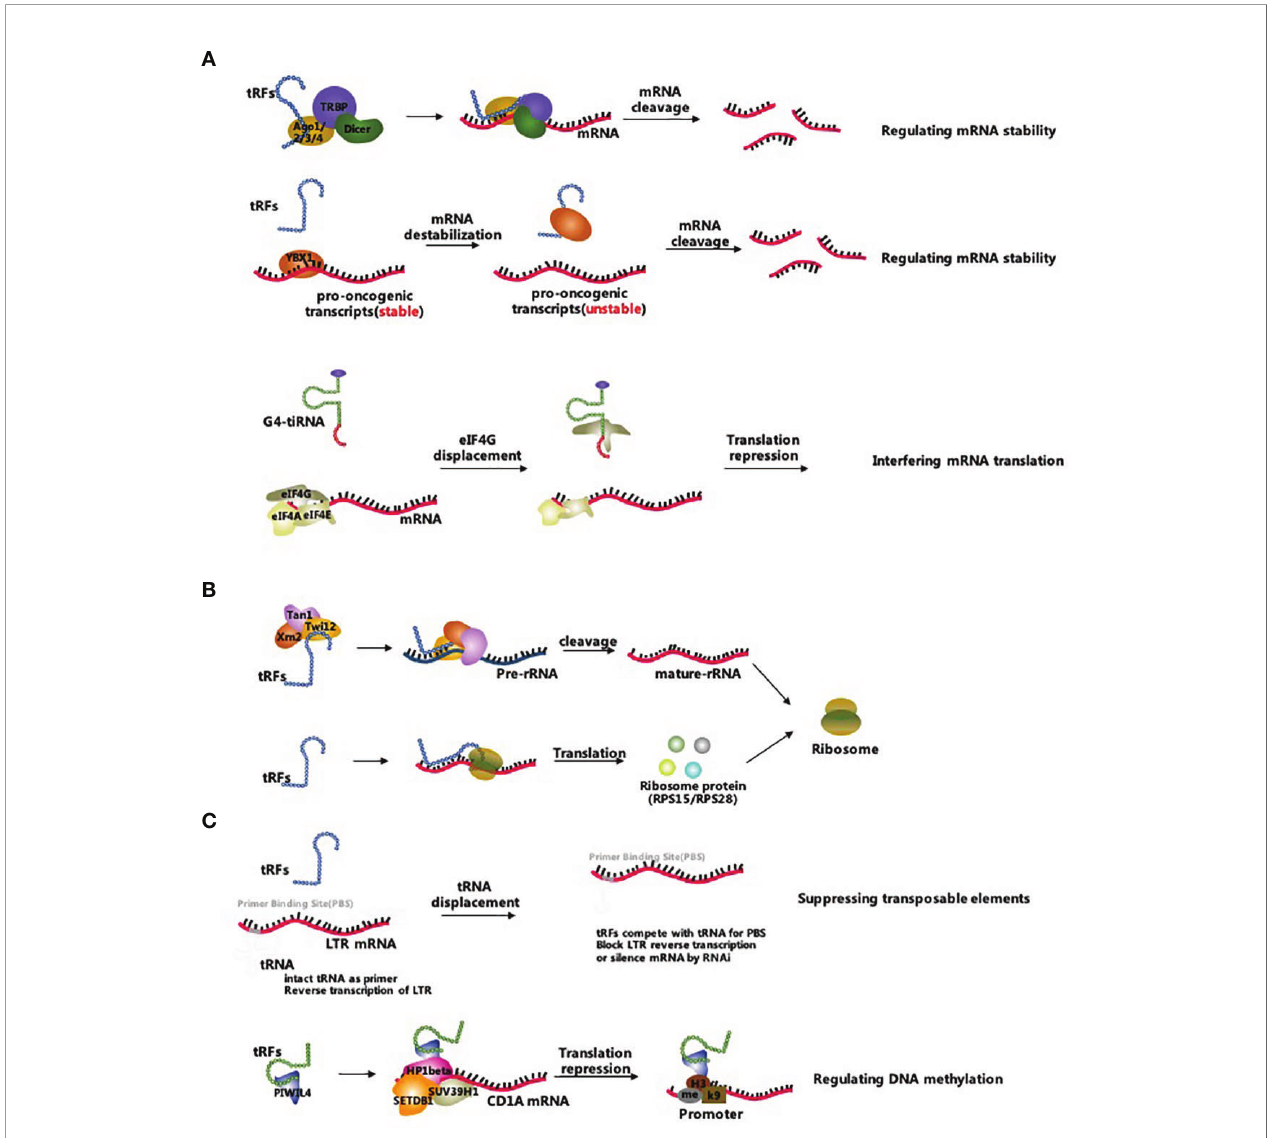
FIGURE 2 | Biological functions of tsRNAs. (A) tsRNAs inhibit mRNA translation by reducing mRNA stability and interfering mRNA translation; (B) tsRNAs promote ribosome biogenesis by regulating rRNAs and ribosomal proteins; (C) tsRNAs regulate epigenetic processes by suppressing transposable elements and targeting the DNA